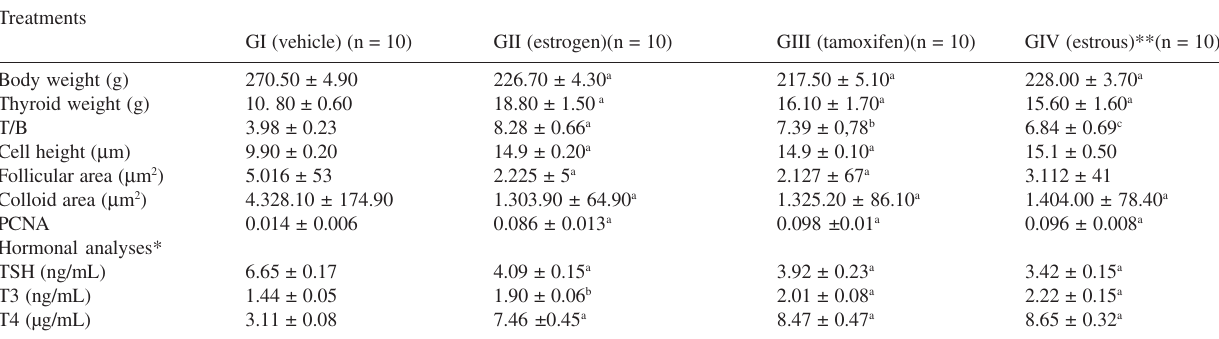
Table 1 - Morphological and functional thyroid data of adult ovariectomized rats treated for 50 days with conjugated equine estrogens (GII), tamoxifen (GIII), or drug vehicle (GI). (mean ± SEM) Treatments